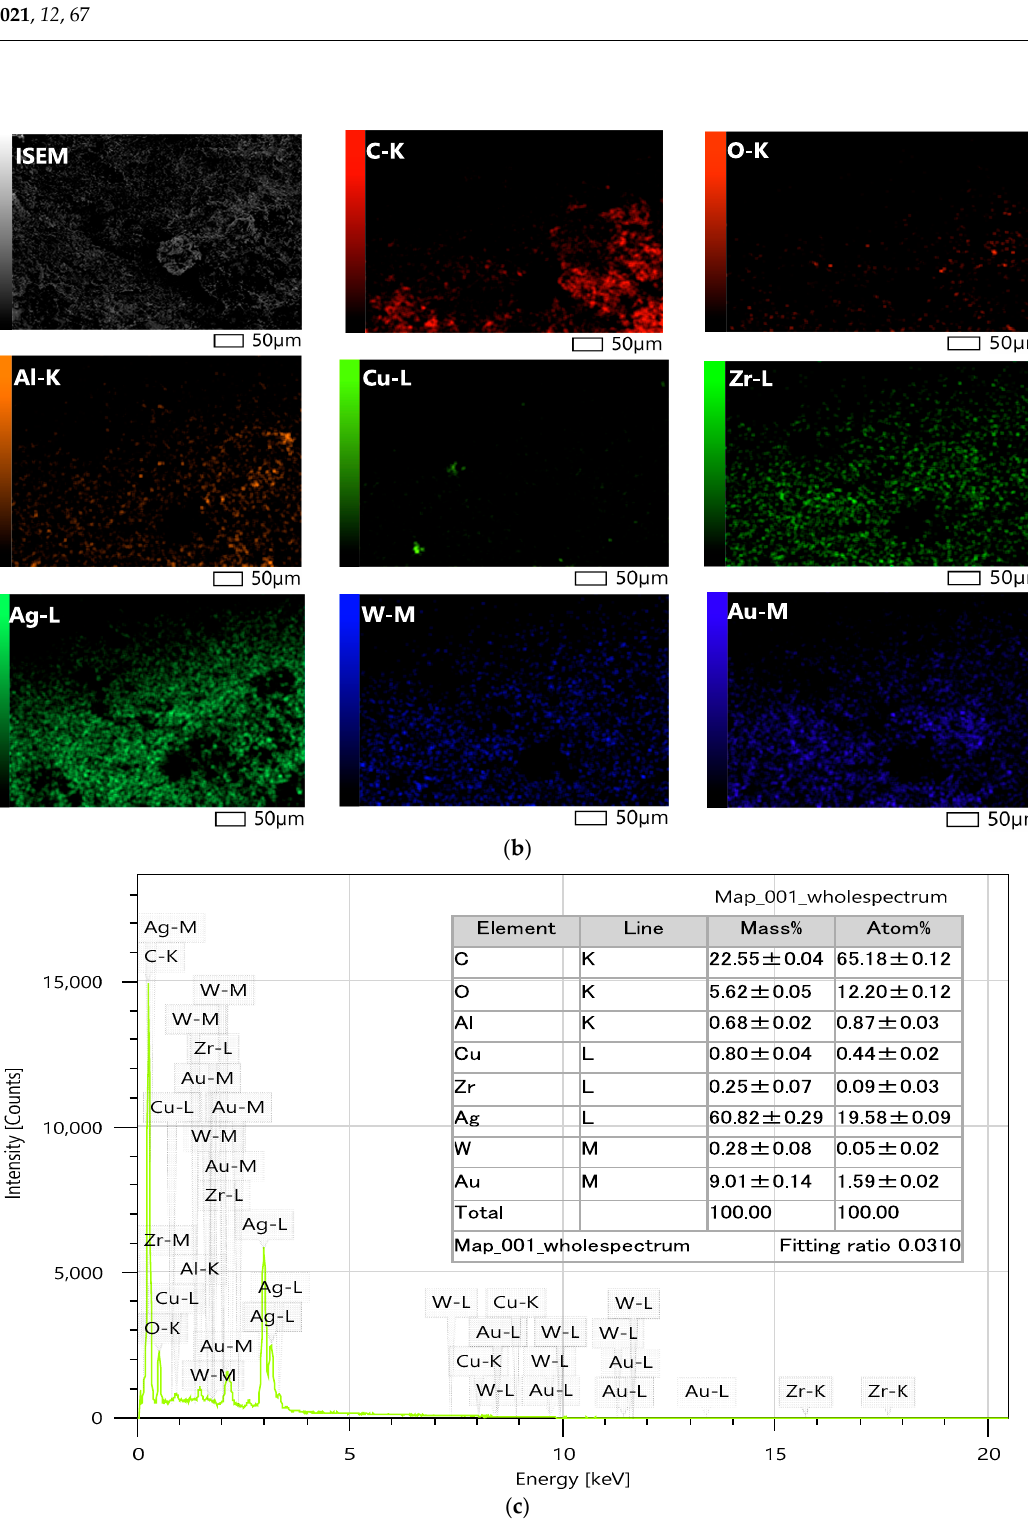
Figure 3. ( a ) Energy dispersive X-ray spectroscopy (EDS) mapping of the machined surface (hole bottom; Exp. #8—Table 3) at machining parameters of 80 V, 1 A, T on = 200 µ s, T off = 250 µ s, ( b ) mapping of individual element showing the locations and intensity of individual elements, ( c ) EDS spectrum analysis showing percentage of different elements present on the machined surface.